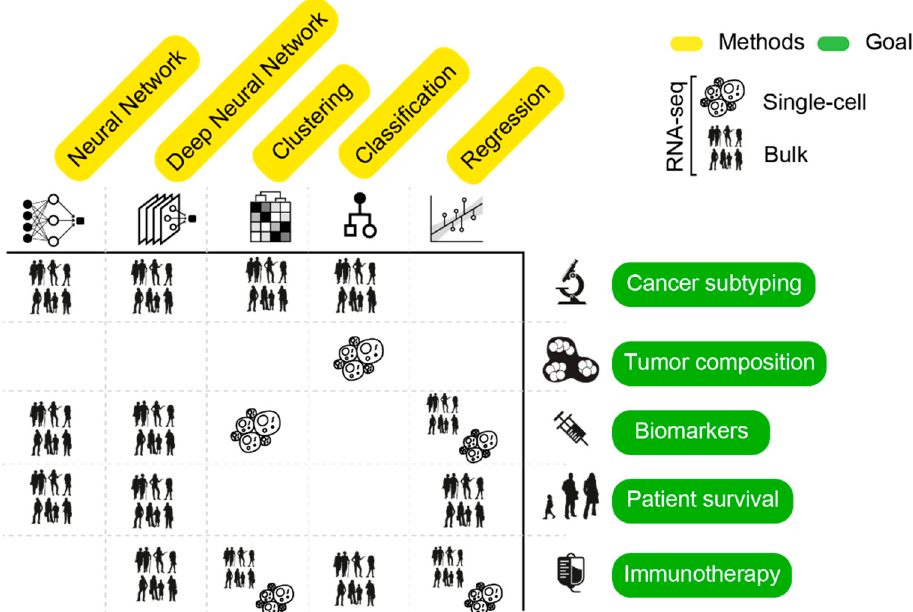
Figure 3. Graphical summary of AI approaches (columns) applied to solve tasks (rows) presented in this review. Cells show the RNA ‐ seq data type used for the analysis. The “immunotherapy” task includes assessment of tumor microenvironment and identification of neoepitopes.